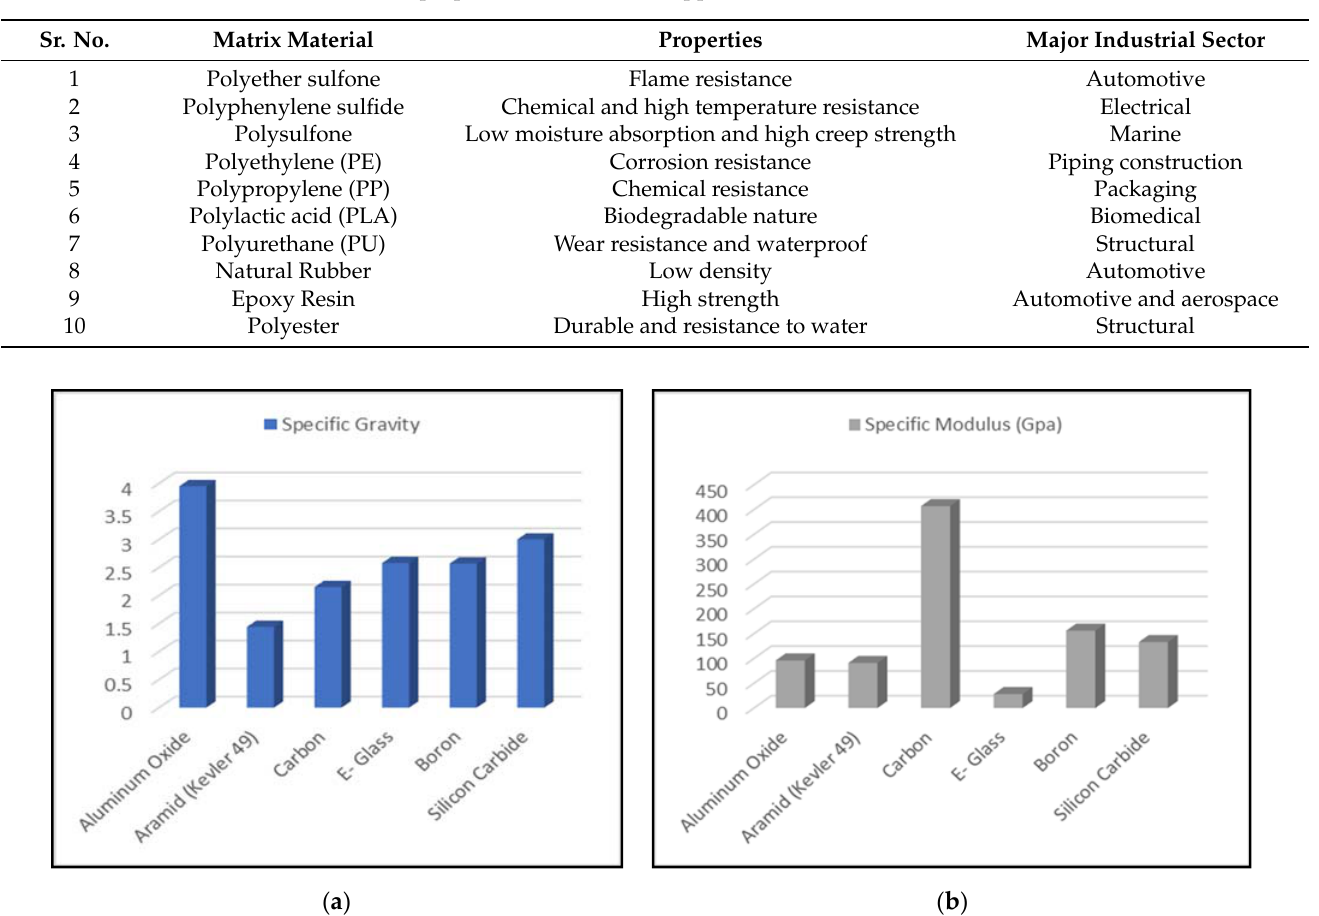
Table 1. Different properties and industrial applications of matrix materials [30–34].